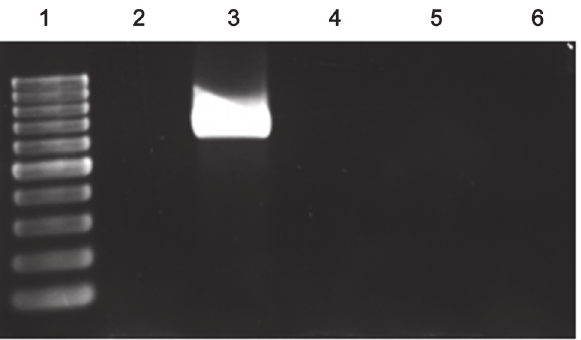
Fig 3. RT-PCR analysis of the I- Sce I expression under the CaCl 2 -temperature inducible promoter Pfpp2. Each PCR was performed with 20 ng of F. psychrophilum RNA. Oligonucleotides homologous to I- Sce I gene, giving an internal RT-PCR fragment of 640 nt, were used. RT-PCRs were performed with RNA from F. psychrophilum THC02/90 strain carrying pCP23 plasmid (lane2) and pCP23-TFS plasmid (lane 3), which were incubated at 12°C and CaCl 2 until early stationary phase. As controls for DNA contamination, PCRs were also carried out with the primers used for RT-PCR analysis by omitting the reverse transcription step, using RNA samples from F. psychrophilum THC02/90 strain carrying pCP23 plasmid (lane 4), pCP23- TFS plasmid (lane 5) and DEPC water as templates. Lane 1: 100 bp molecular marker